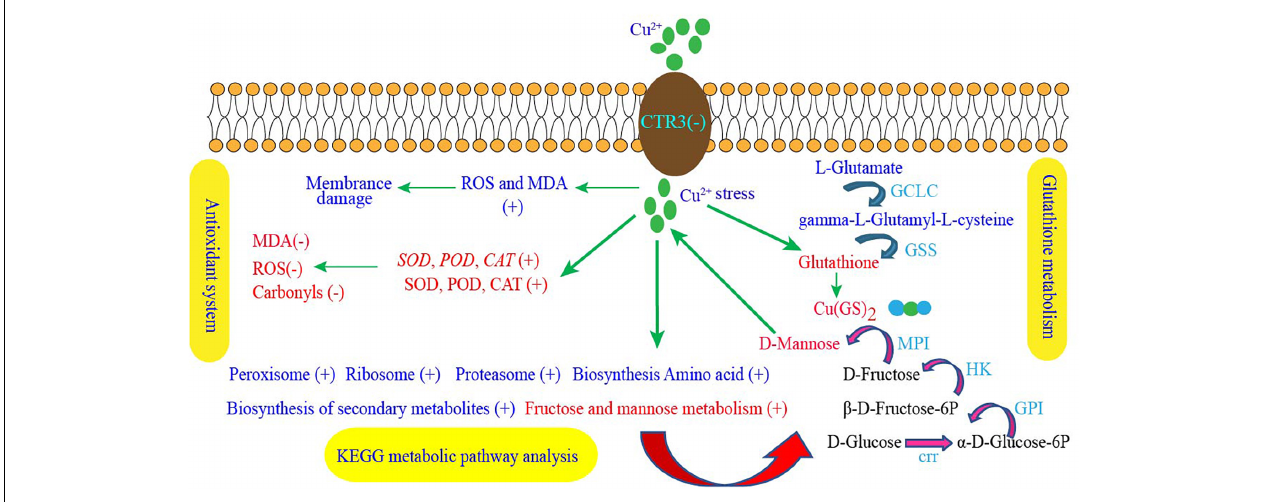
FIGURE 6 | GXDK6 copper ion tolerance mechanism. “ + ” Indicates that the metabolic pathway, gene expression, enzyme activity, or substance content significantly upregulated under copper stress, whereas “–” indicates that the gene expression, enzyme activity, or substance content significantly downregulated compared with that in the copper ion-free